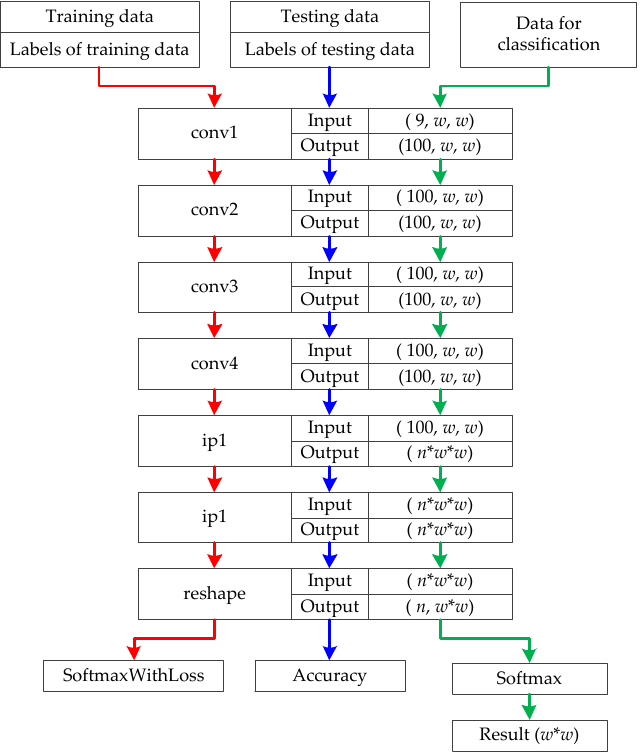
Figure 2. The structure of FFS-CNN. The red arrows and blue arrows show the training procedure and green arrows show the classification